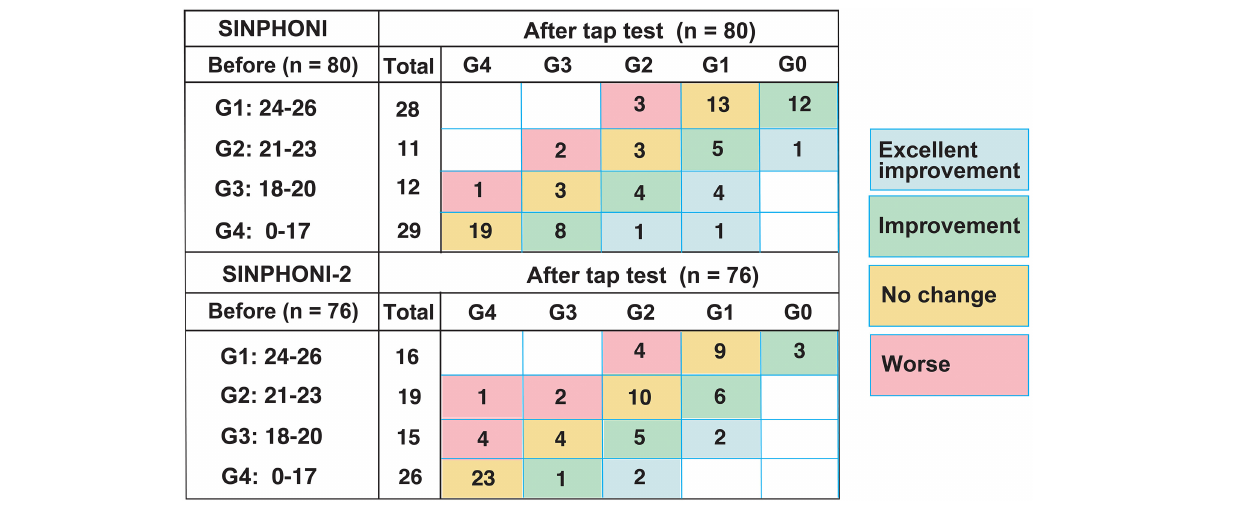
intervention was A-OR 1.06 (0.26–4.39) and M-OR 1.18